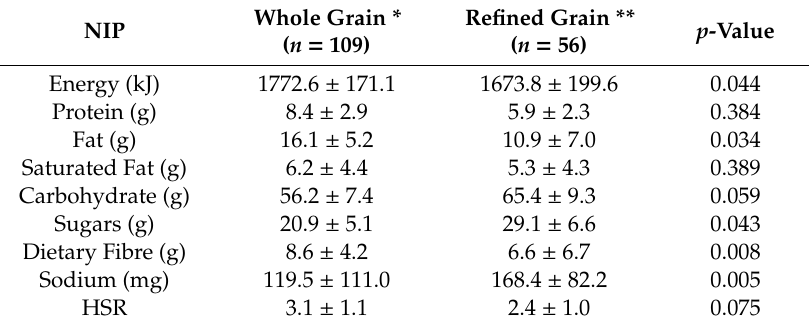
Table 5. Whole grain versus refined grain nutrients (per 100 g) (mean and